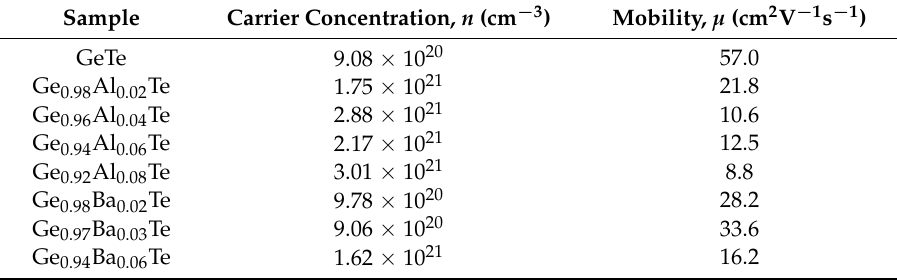
Table 1. Hall measurement results (at ~300 K) of carrier concentration ( n ) and mobility ( µ )